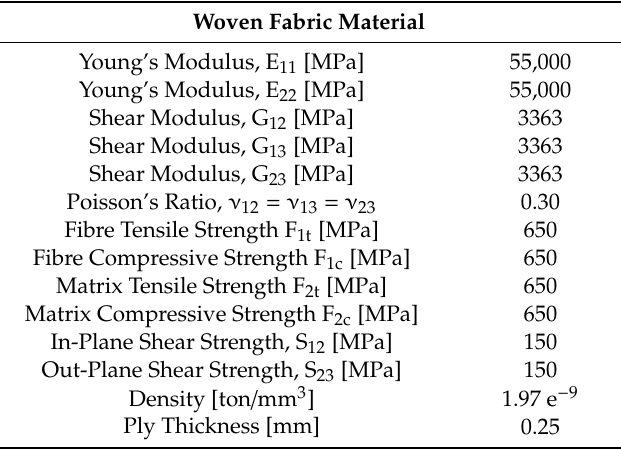
Table 3. Woven fabric material system properties.